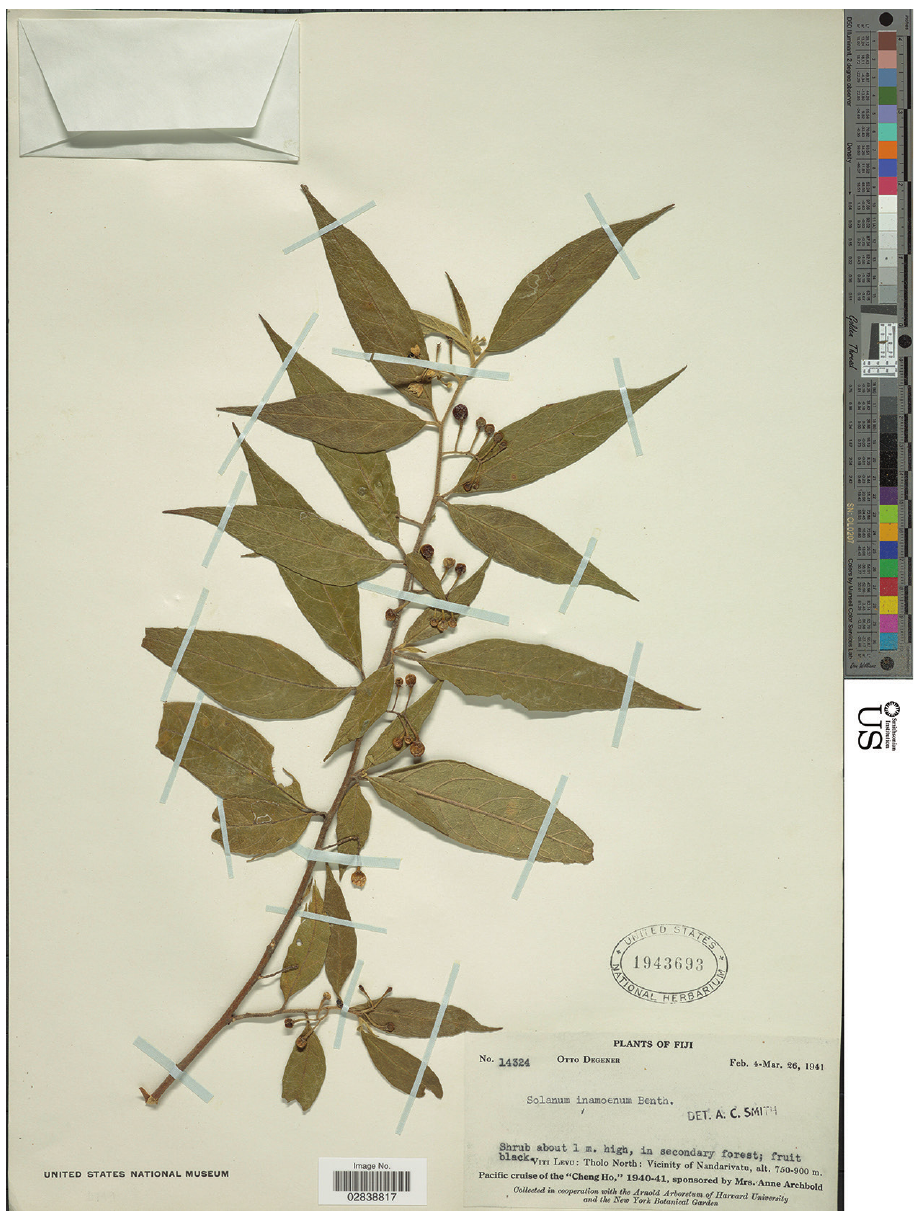
Figure 10. Solanum ratale D.McClelland (isotype Degener 14324 , US [acc. # 1943693, barcode 02838817]). Type. Fiji. Viti Levu: Mba, (Tholo North), Western division, village of Nadari- vatu, Fish Hatchery 2600 ft, 9 Feb 1941 (fl, fr), O. Degener 14324 (holotype: A; isotypes: K [K000922635, K001155453], UC [acc. #1016245], US [acc. #1943693, barcode